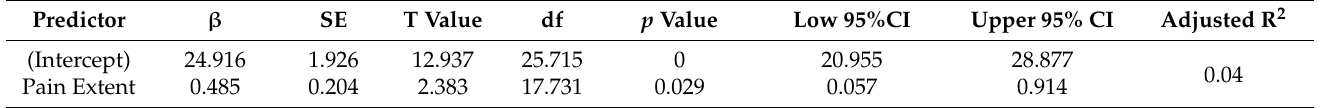
Table 6. Crude association between baseline pain extent to 2 years NDI outcome.